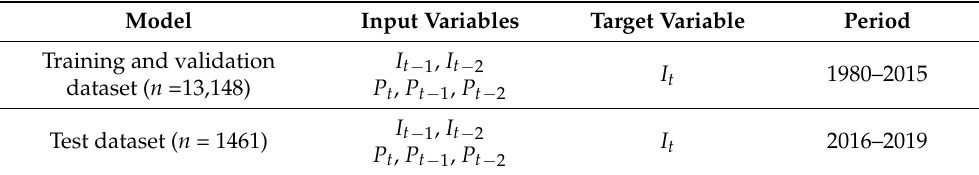
Table 1. Dataset used to develop AS ensemble